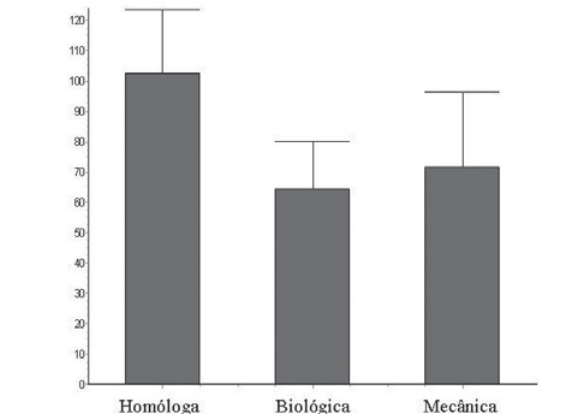
Fig. 2 - Tempo médio de pinçamento aórtico, em minutos, com desvio padrão, para os diferentes tipos de próteses. Observa-se que há diferença com significado estatístico desfavorável ao grupo da valva homóloga. Utilizou-se o teste ANOVA